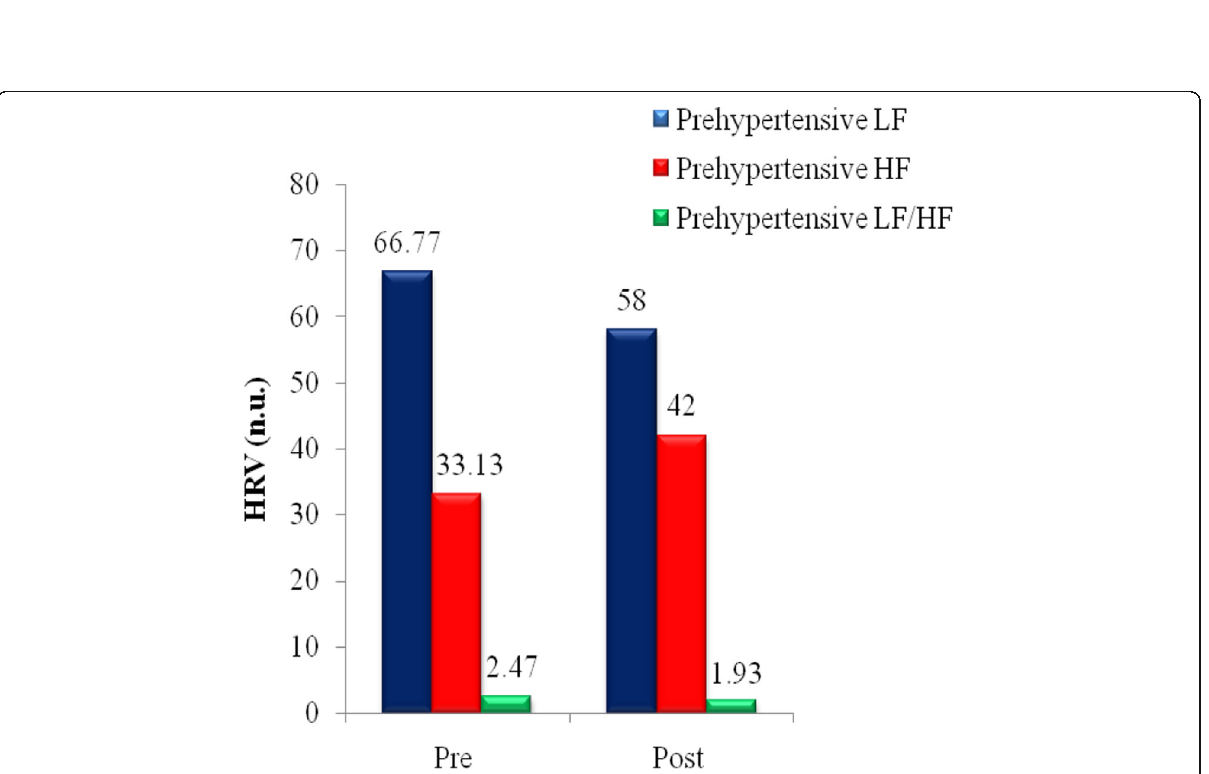
Fig. 3 Pre- and post-comparison of heart rate variability in pre-hypertensive group in gradient exercise testing. Abbreviations : HRV heart rate variability; LF low frequency (denotes heart rate variability); HF high frequency (denotes heart rate variability); LF/HF ratio of low frequency and high